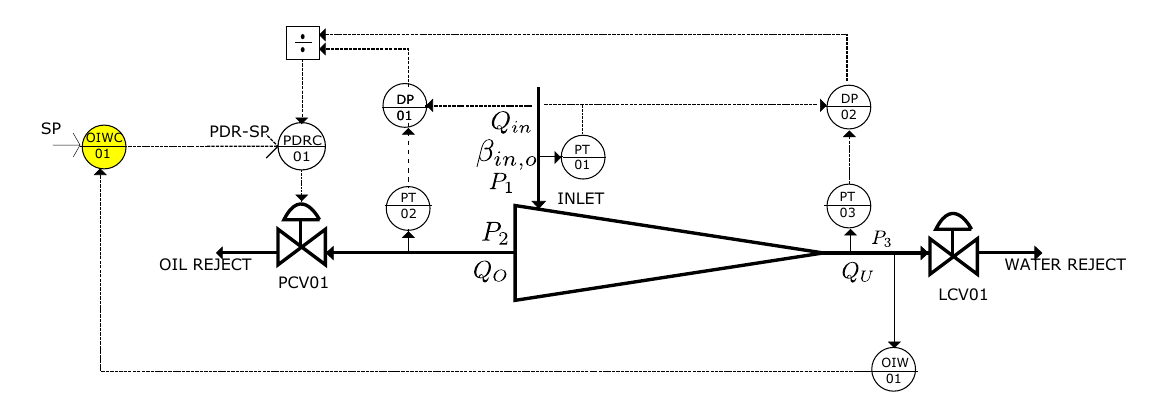
Figure 8: A diagrammatic representation of the cascade approach adjusting the PDR setpoint